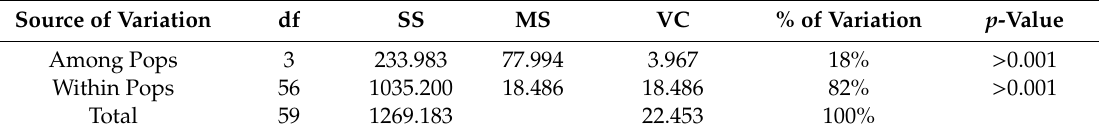
Table 5. Analysis of molecular variance (AMOVA) within and between provenances of A. spinosa. Source of Variation